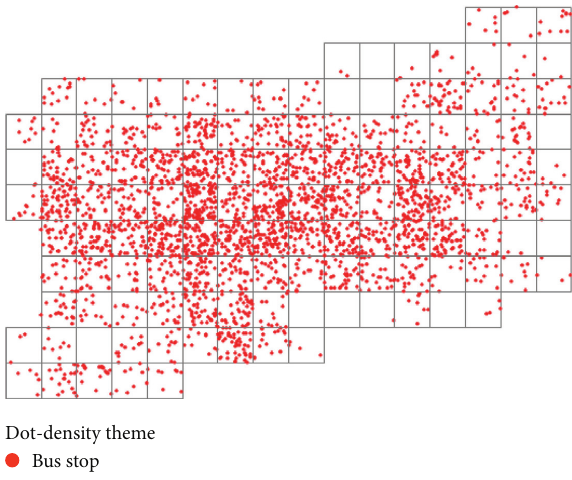
Figure 5: Bus stop density (unit: point/square mile).